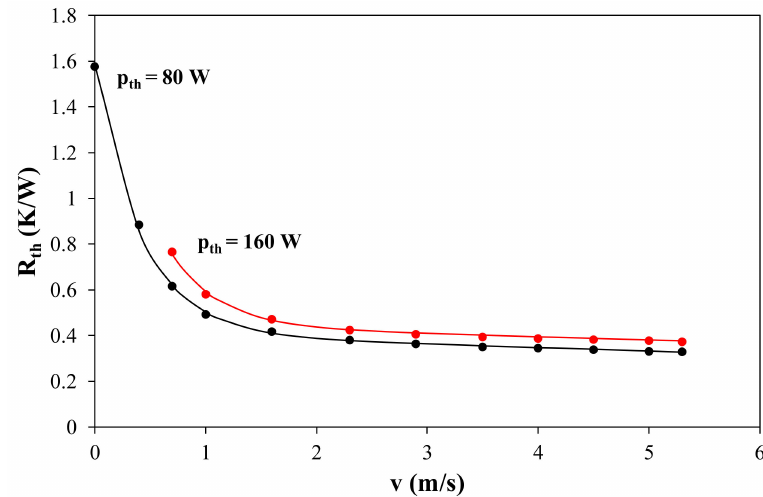
Figure 13. Measured and modelled dependences of the thermal resistance of the resistor mounted on the heat sink with a silicon paste on the airflow speed at selected values of the dissipated power (system C).